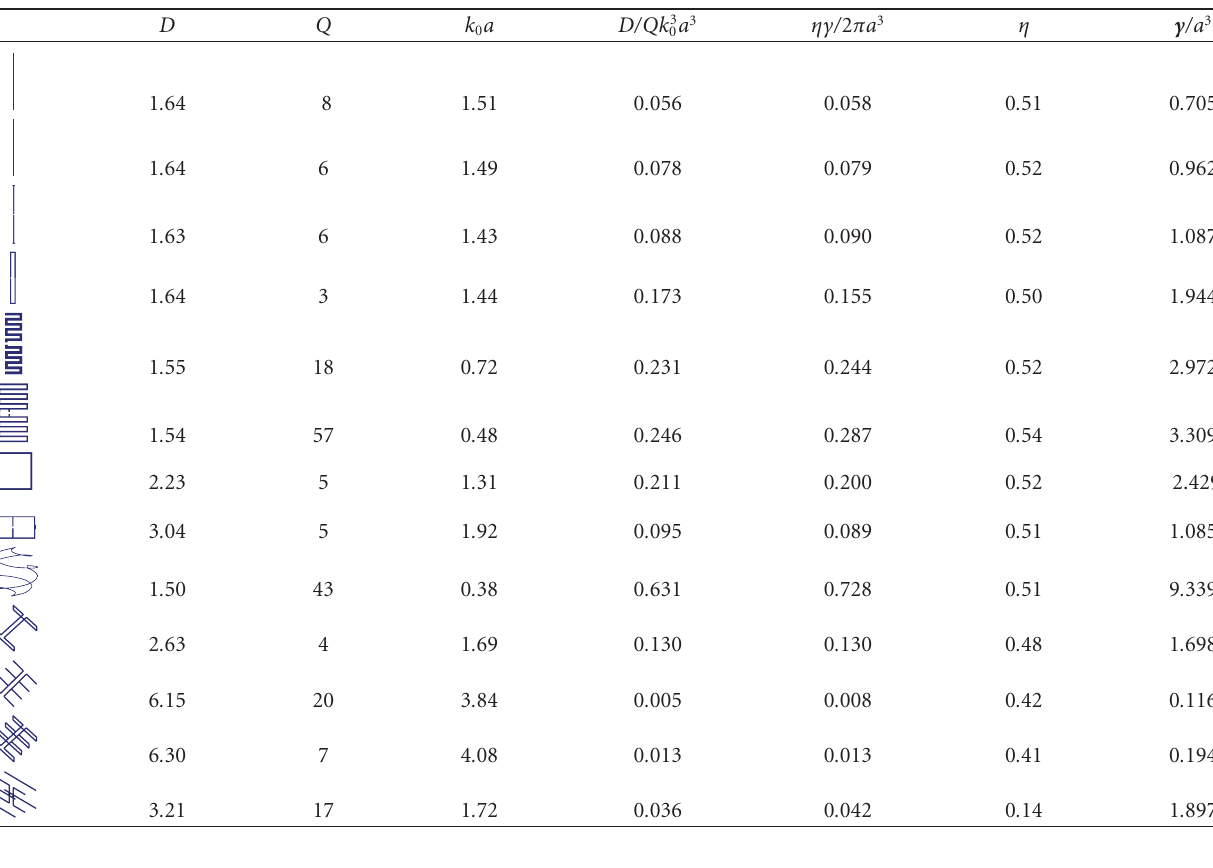
Table 1: Numerical results of the antennas in Section 3.3.